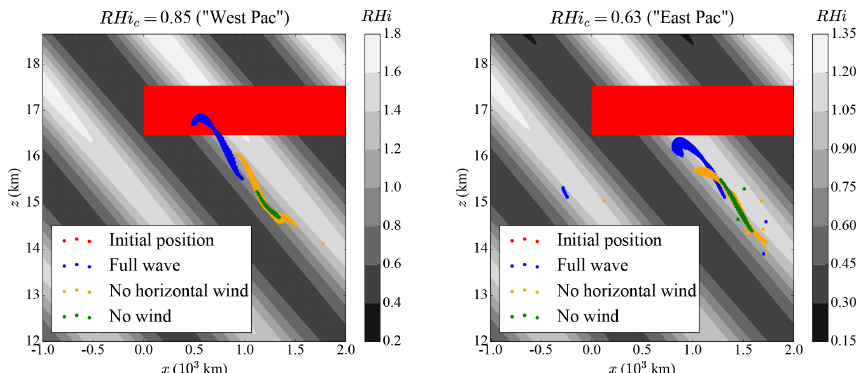
Figure C1. Same as Fig. 6, but including ice crystal positions from simulations with the wave vertical wind accounted for but not the horizontal one (orange). As in Fig. 6, the blue dots are the ice crystals’ positions for the full simulation (wave advection and temperature fluctuations), and the for the green dots both the horizontal and vertical winds induced by the wave have been neglected. The initial ice crystal radius used in both cases for all crystals is